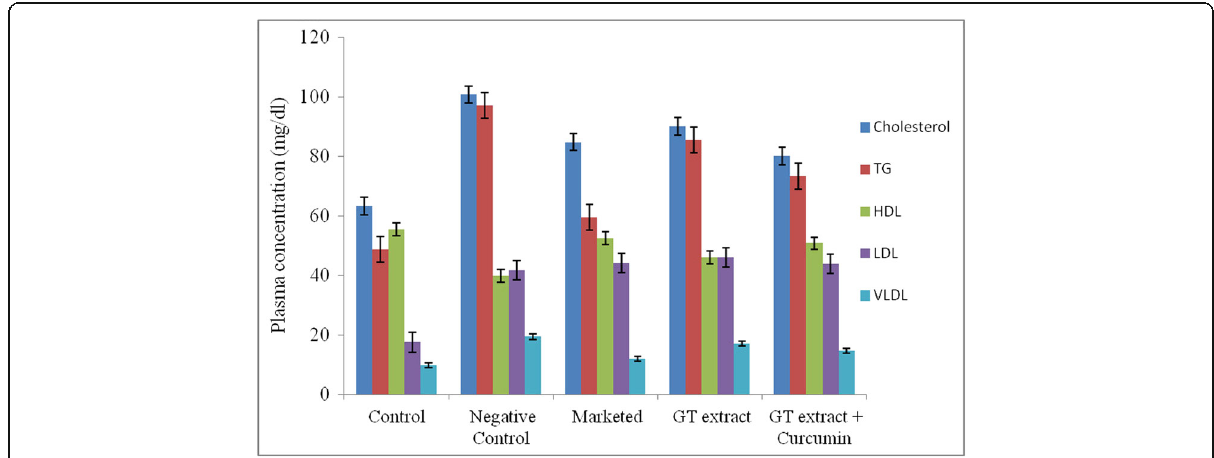
Fig. 5 Lipid profile of in-vivo study in rats. Data is expressed as Mean ± SD of n = 4, statistical significance P <